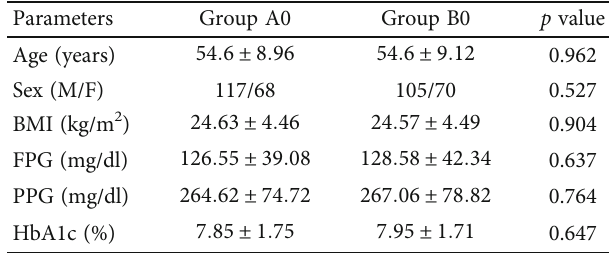
Table 1: Baseline demographic and clinical characteristics of study subjects of two